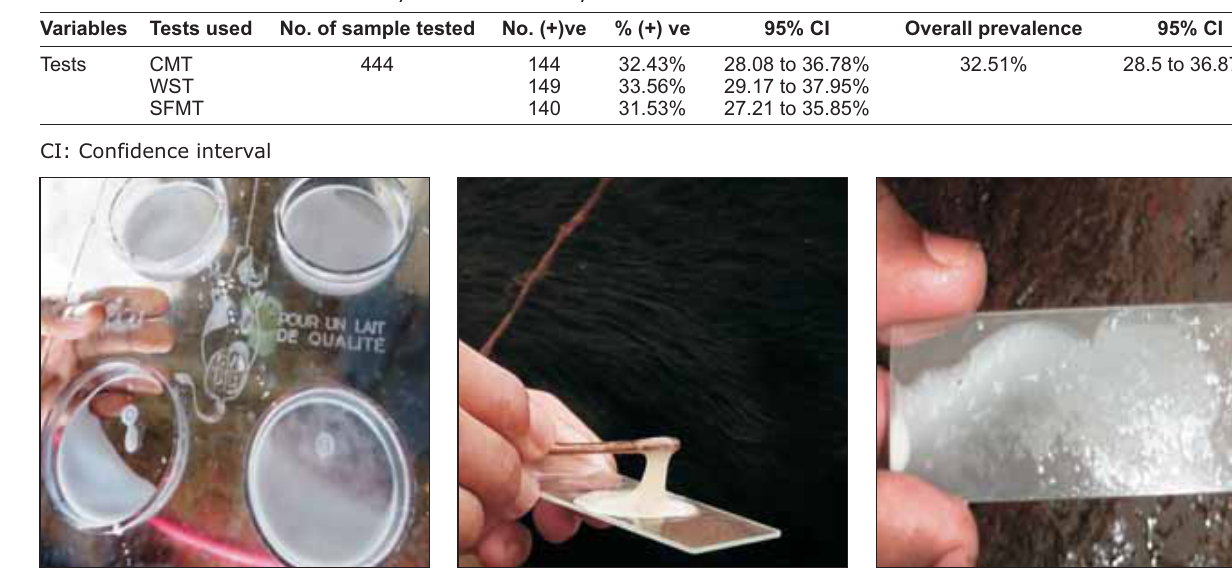
Figure-1(b): Positive White Slide Test (Large masses of coagulated materials